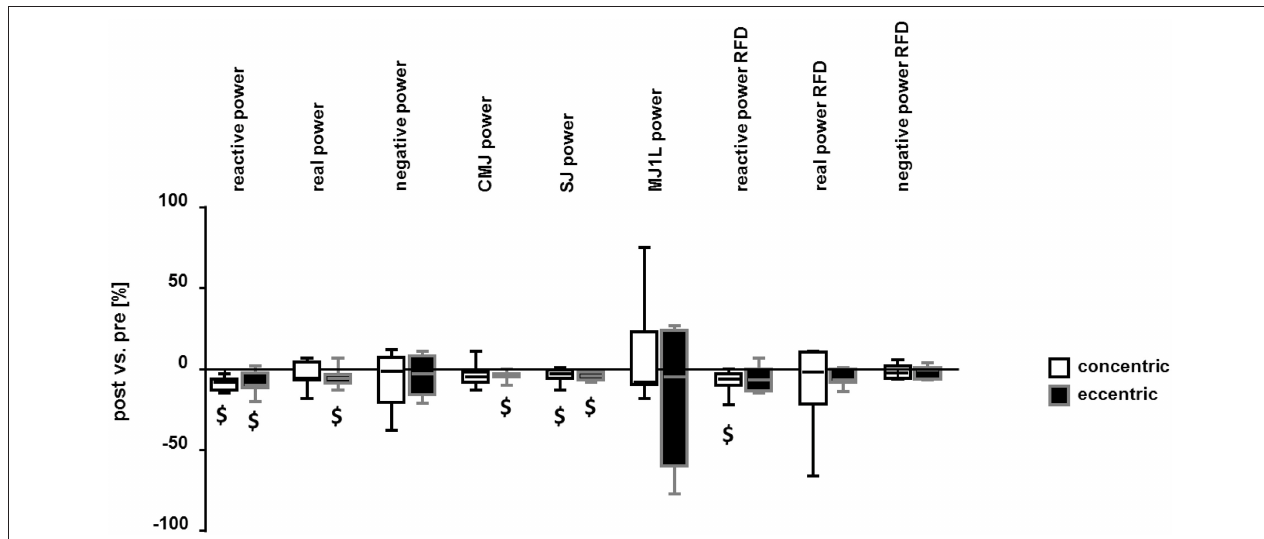
FIGURE 3 | Reduction in mechanical output after interval exercise on the soft robot. Box Whisker plots visualizing the median + standard error (box and central line) and minima/maxima (whisker) of the post- vs. pre- exercise differences in Ppeak and the RFD for the concentric and eccentric protocol, respectively. Power values were assessed by the two-legged reactive power test, real power test, negative power test, CMJ, SJ, and the one-legged multiple jumps. RFD was determined for the reactive power test, real power test and negative power test. $: p < 0.05 vs. pre (see Table 1 ). Repeated ANOVA for the repeated factors of time point relative to the exercise on the soft robot (i.e., pre, post) and exercise protocol (i.e., concentric, eccentric) with post-hoc test for least significant